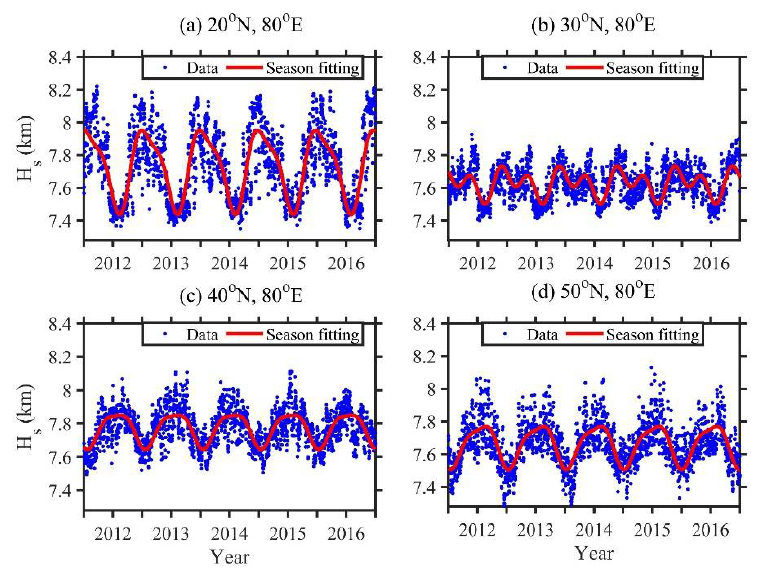
Figure 2. Time series for the ZTD height scale factor ( H s ) and corresponding seasonal fits.